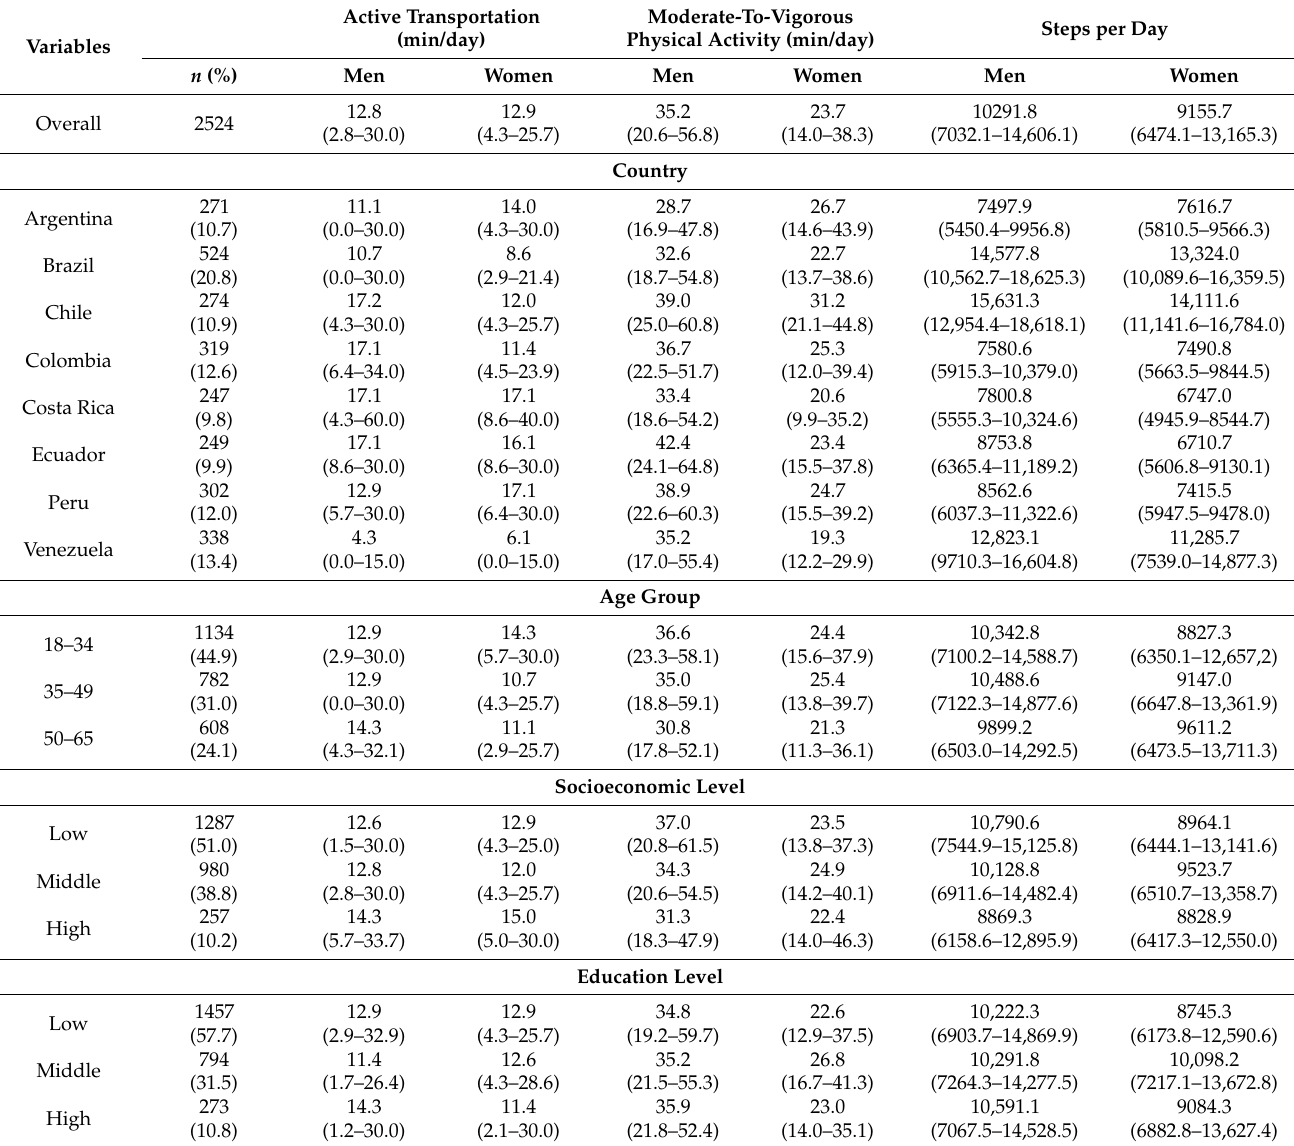
Table 1. Sociodemographic characteristics (median [25–75]) according to active transportation, moderate-to-vigorous physical activity and steps per day in adults from Latin